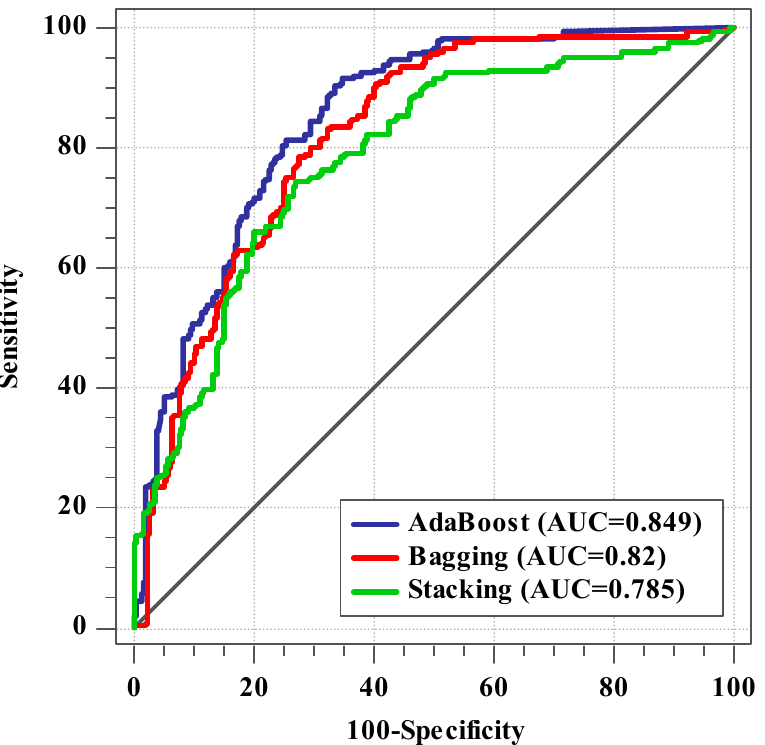
Figure 7. ROC curve results by three algorithms.